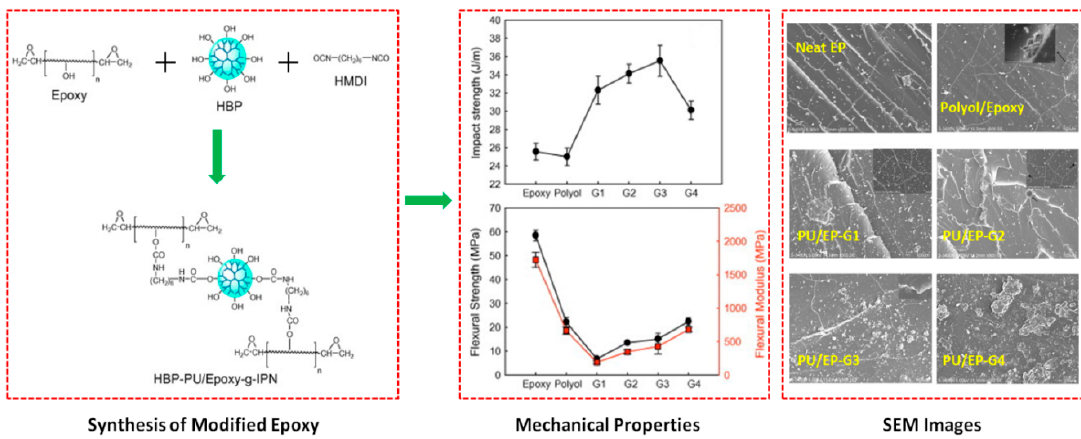
Figure 7. Schematics of the formation of modified epoxy system using HBPs; Impact strength, flexural strength and flexural modulus of pure epoxy, linear polyol base epoxy and modified epoxy samples having different generations of HBPs (HBP-G1 to HBP-G4); SEM images of pure epoxy, linear polyol base epoxy and modified epoxy samples having different generations of HBPs; Reprinted with permission from ref. [13], Copyright [2013], Elsevier.